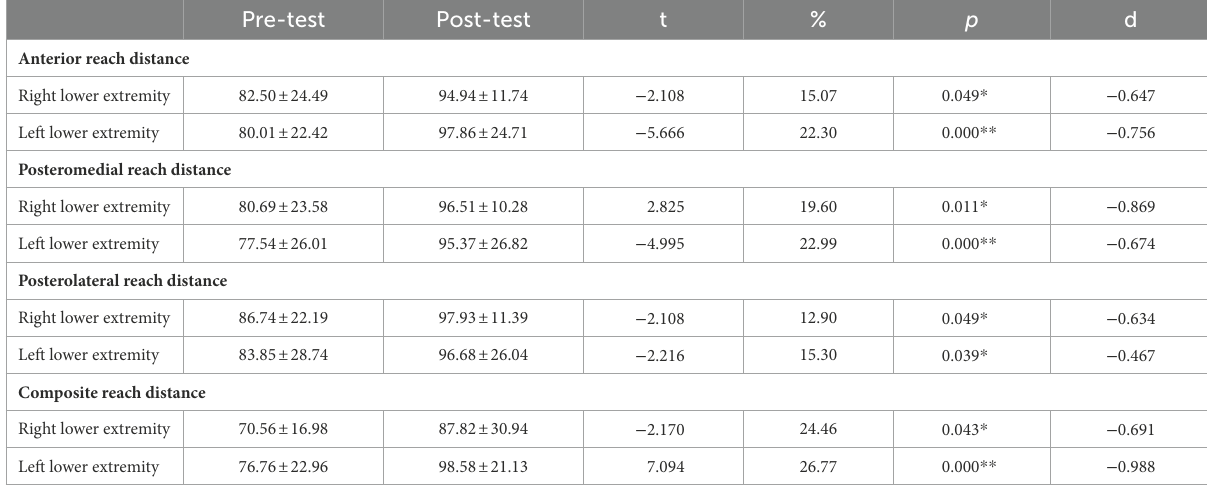
TABLE 4 Paired group T -test results conducted to determine whether there is a significant difference between the experimental group balance motor performance capacity pre–post-test Y Balance Test ANT, PM, PL and Composite reach distance mean